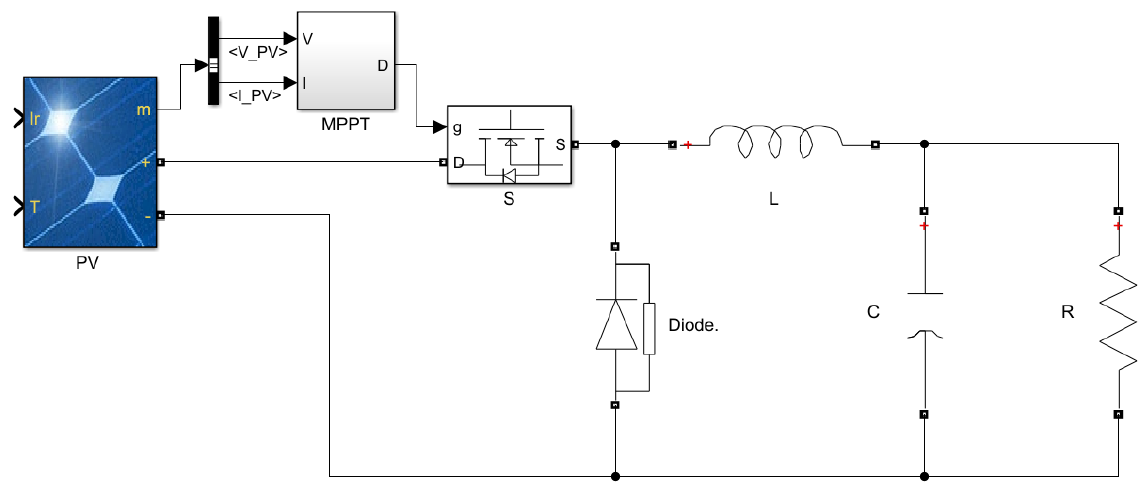
Figure 4. Perturb and observation control system.